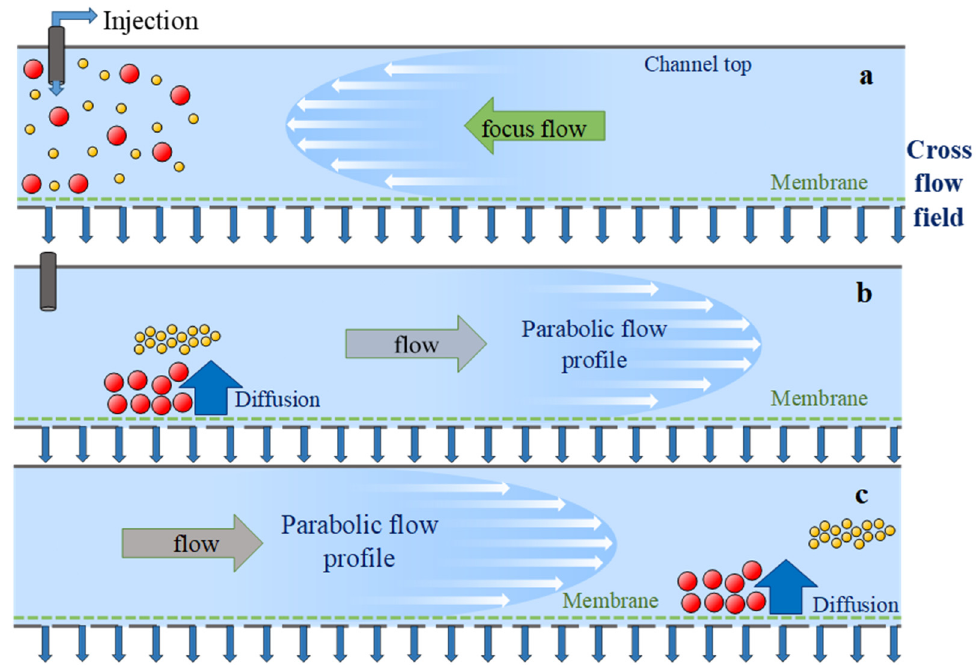
Figure 1. Schematic on the working principle of AF4: ( a ) Injection and sample focusing, ( b , c ) sample fractionation.